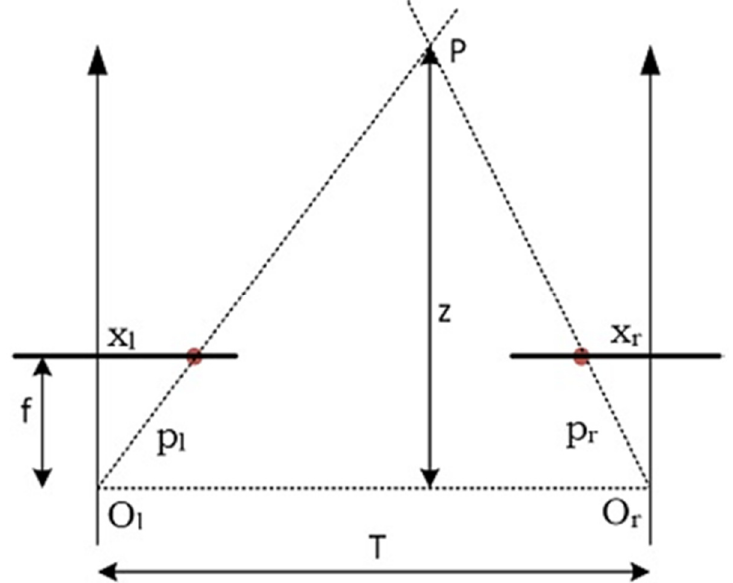
Figure 3. Graph of binocular disparity calculation from a single scene.